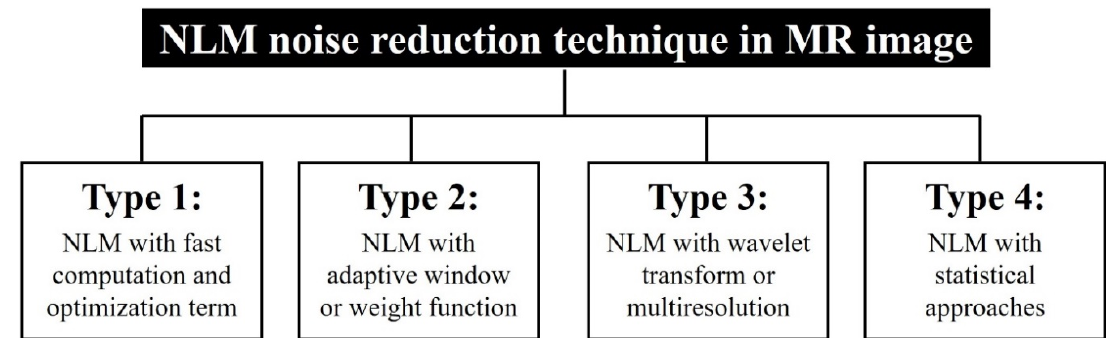
Figure 1. Types of non-local means (NLM)-based noise reduction techniques for magnetic resonance (MR) images.